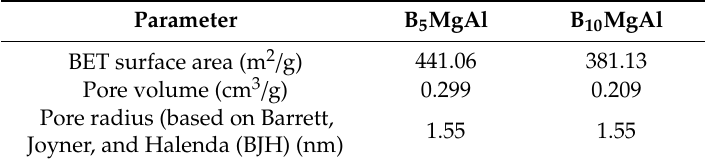
Figure 3. N 2 adsorption/desorption of biochar/MgAl composites. Table 2. Textural characteristics of biochar–MgAl composites.